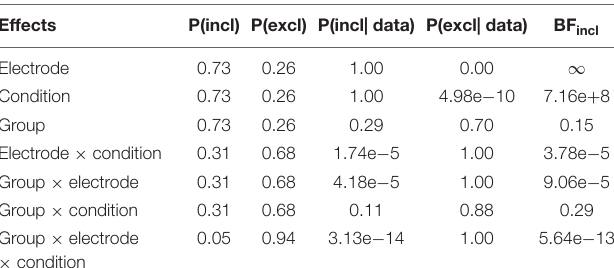
TABLE 6 | Analysis of